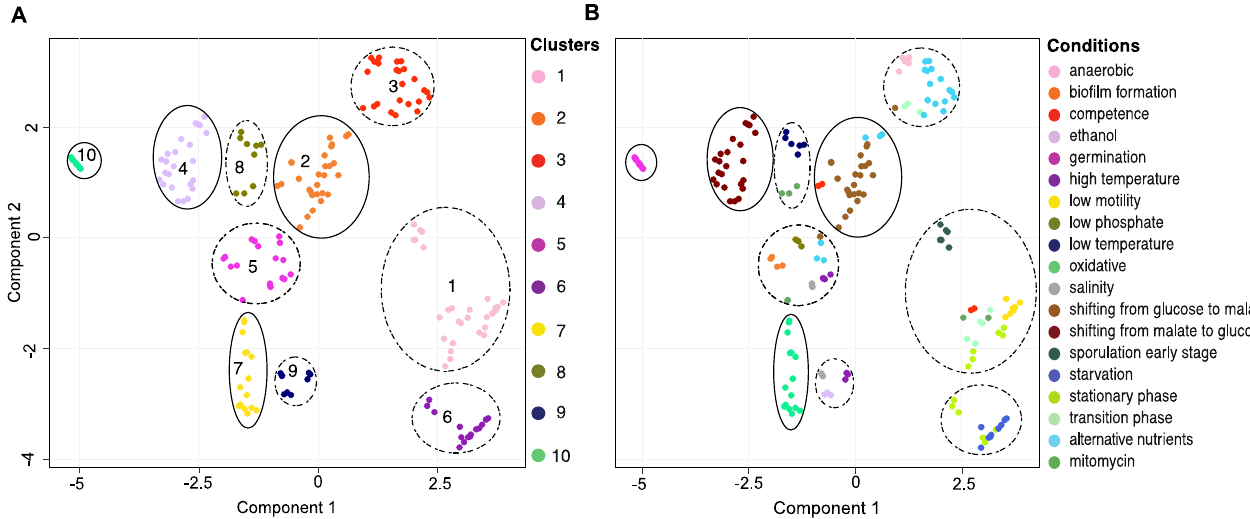
Figure 2. Transcriptional landscapes. ( A ) Transcriptional landscape in UMAP embedding, where samples (data points) with similar transcriptional profiles are positioned close to each other. Ten clusters were identified as indicated by colour. ( B ) Transcriptional landscape in UMAP embedding colour-coded according to the conditions in which they were grown. Clusters containing samples predominantly grown in similar conditions are circled with full lines. Clusters containing samples grown in multiple different conditions are circled with dotted